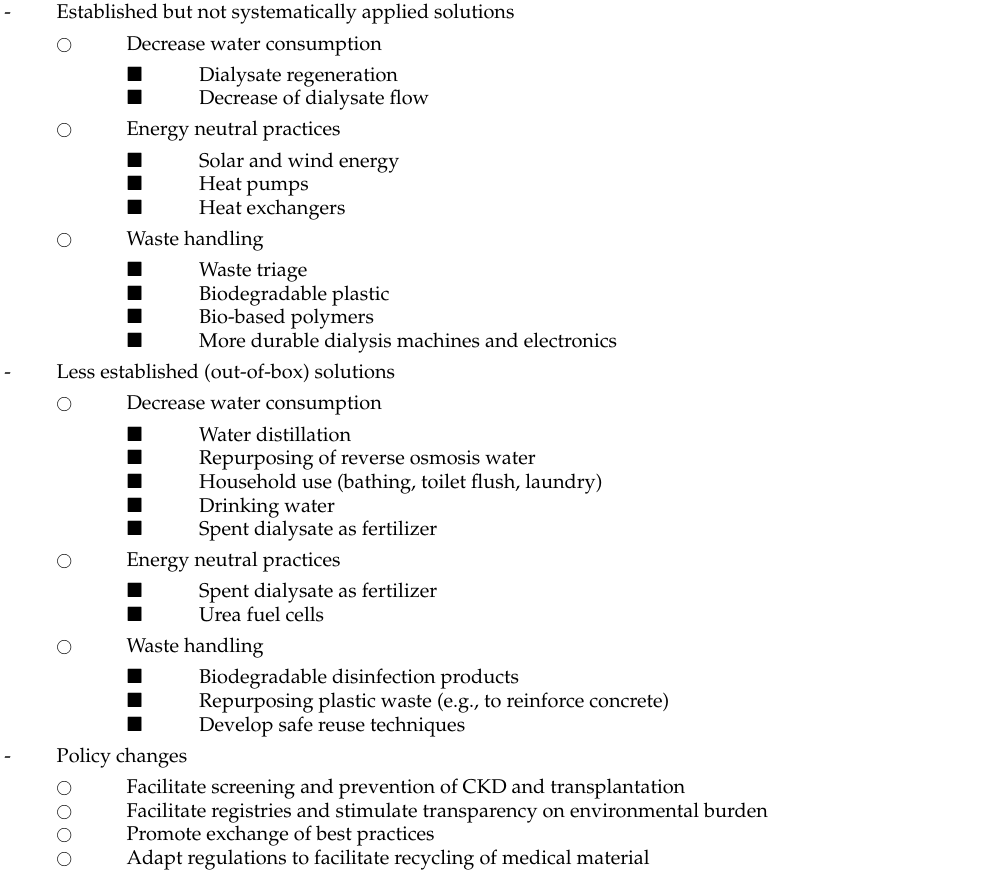
Table 1. Main solutions for environmental problems of dialysis